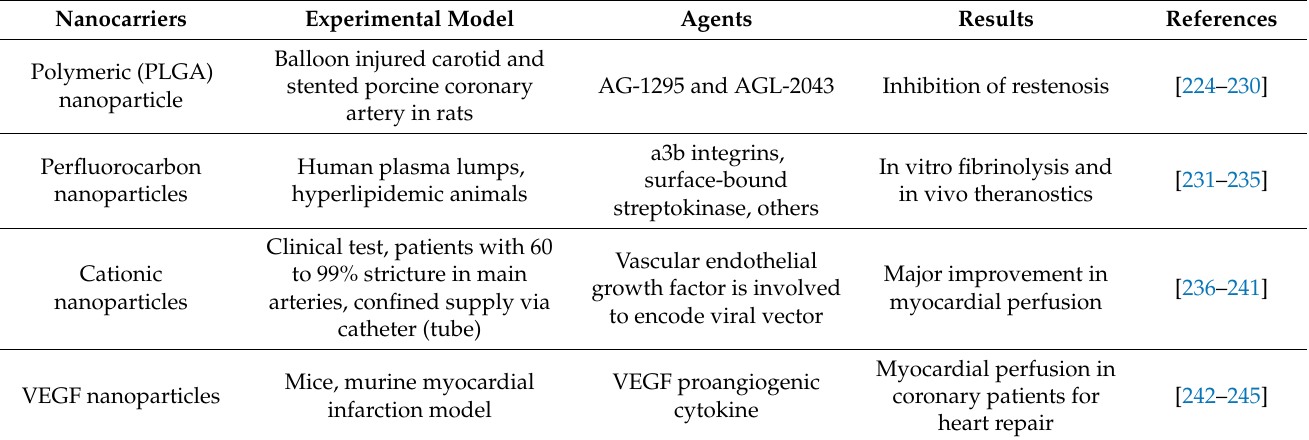
Table 6. Different forms of NPs; their experiment studies show its role in treatment of heart